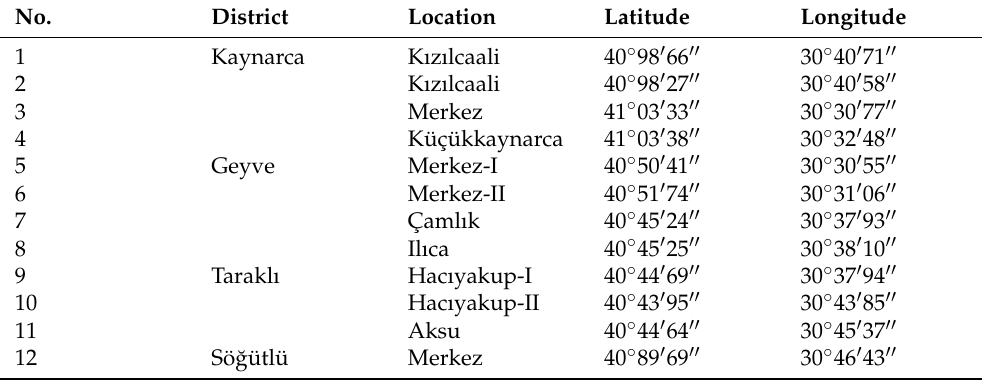
Table 5. Sequenced Heterodera filipjevi samples were collected from wheat fields in Sakarya Province. No.